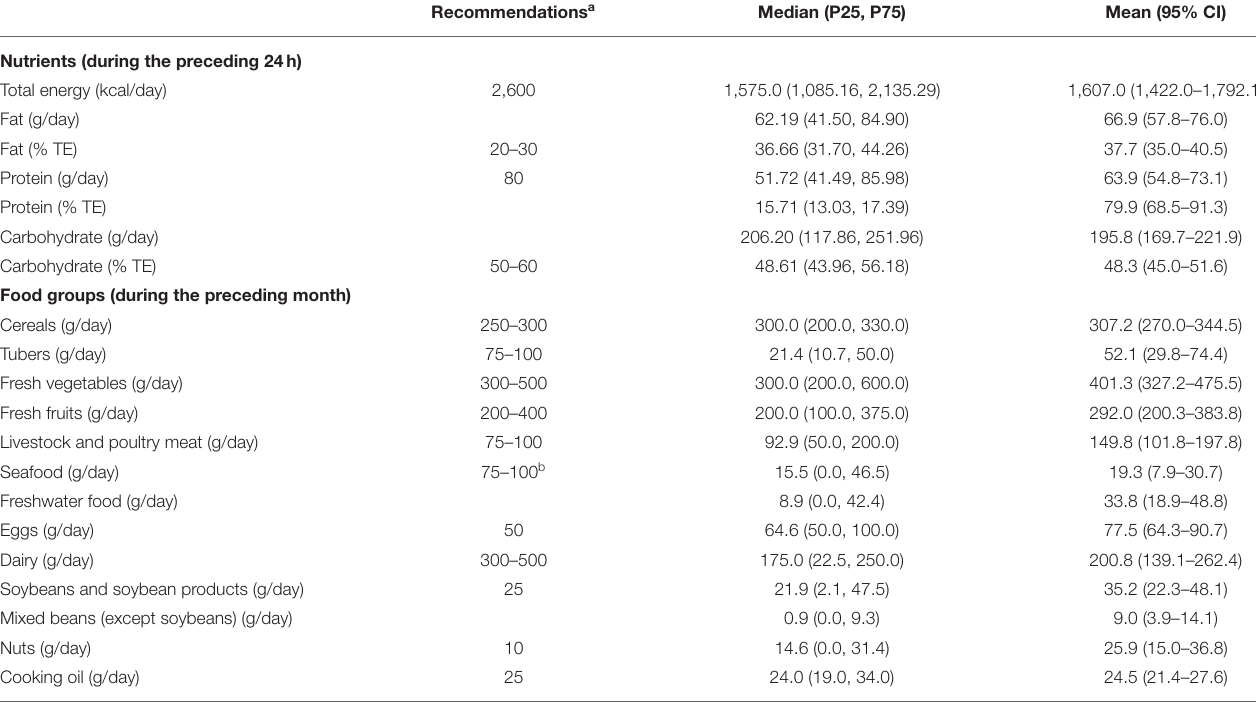
TABLE 2 | Dietary intake of lactating mothers ( n =